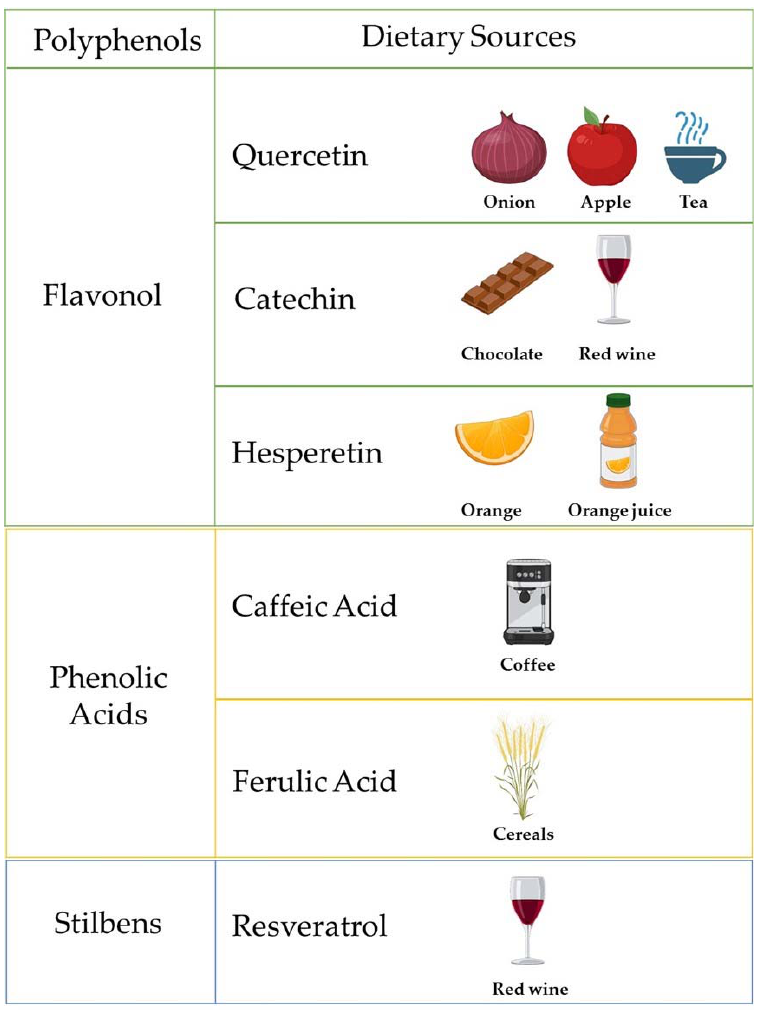
Figure 1. Schematic representation of polyphenols and their related dietary sources. Created with BioRender.com.